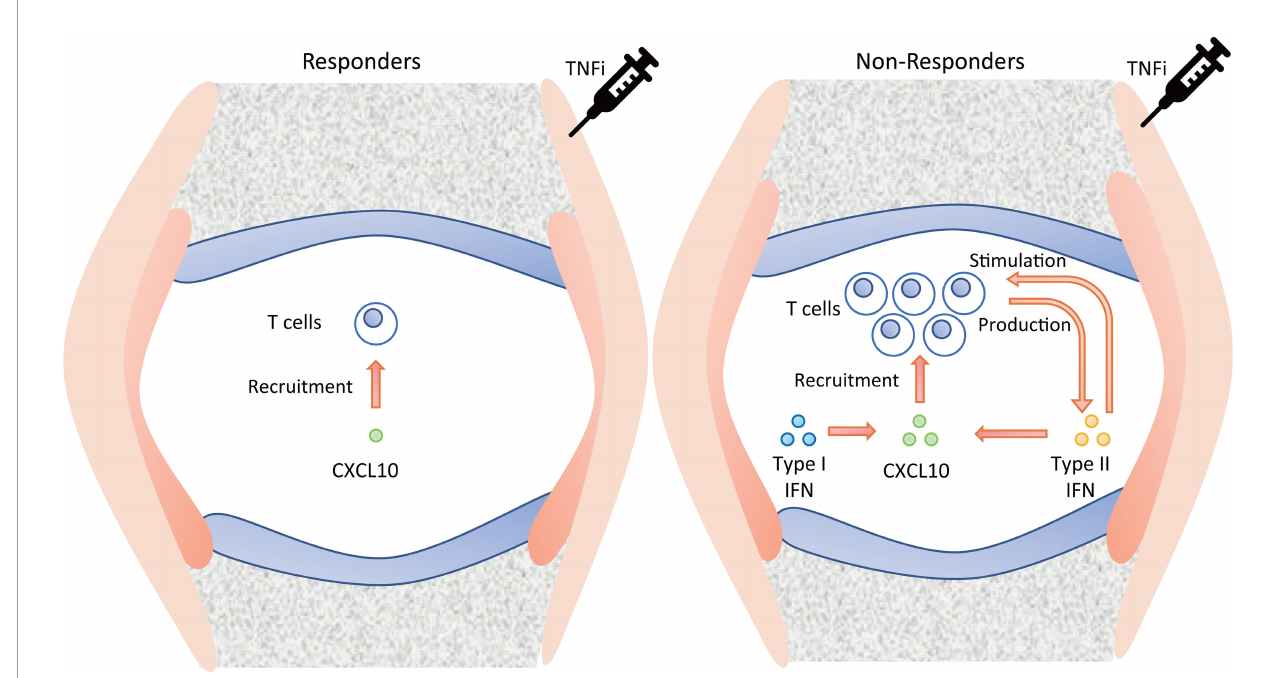
FIGURE 7 | Suggested pathology of the synovium in TNFi responders and non-responders. TNFi, tumor necrosis factor